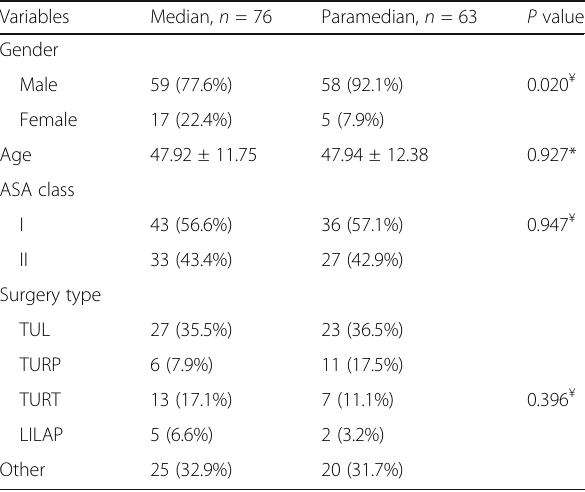
but was not significant ( p = 0.094). The number of with during spinal two groups (Table 2).